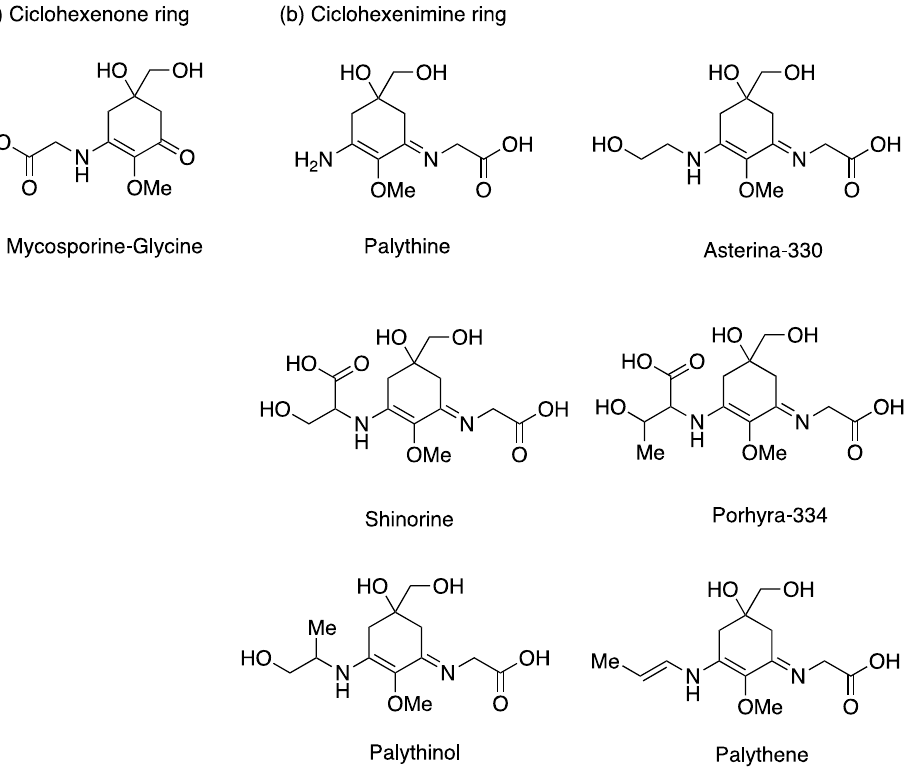
Figure 1. MAAs’ chemical